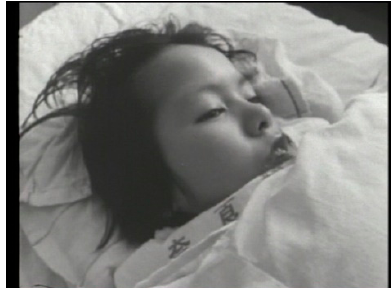
Figure 4. The medium shot of Kumiko awake in bed. Still from The Children of Minamata are Living (1965), director Tsuchimoto Noriaki.